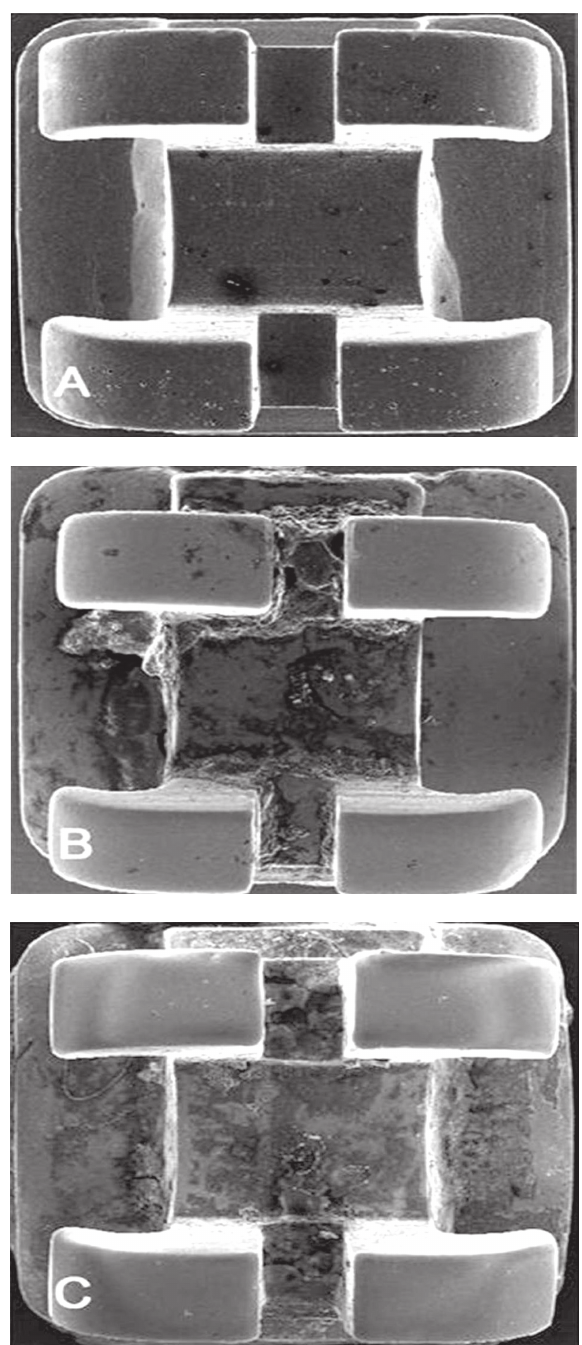
Figure 4- Changes stemming from use and consequent exposure to the intraoral medium. New bracket (A), after 12 months of use (B), and after 24 months of use (C), all with 15x magnification